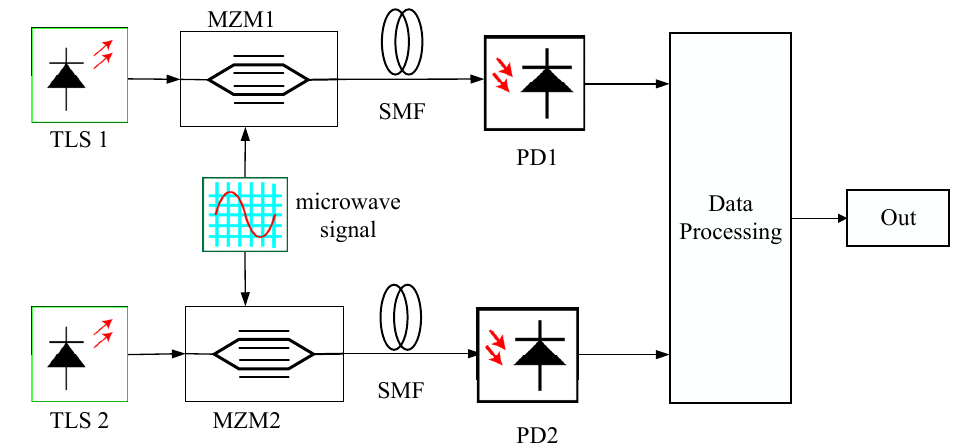
Figure 3. Schematic diagram of the proposed IFM system. TLS: tunable laser source.